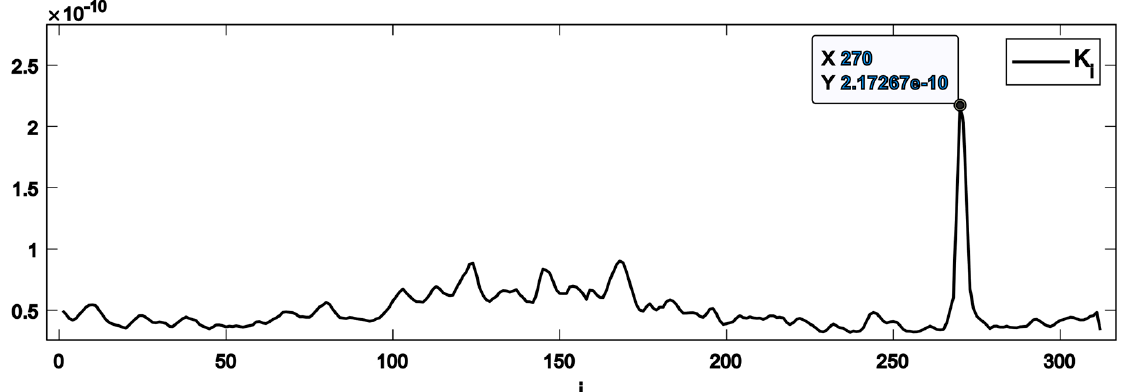
Figure 5. An example of the K -spectrum. Here the index, i , denotes the sequential number of the windows. It is only related to a specific axle angular position if the sought behaviour excites an AE pulse once per revolution of the axle ( f fault = 1/ rev